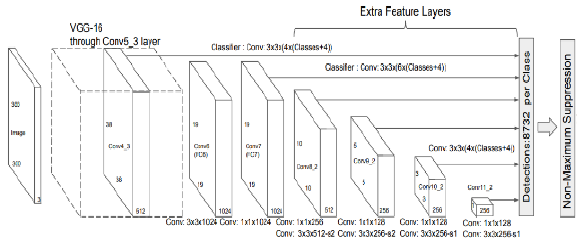
Figure 2. Single Shot MultiBox